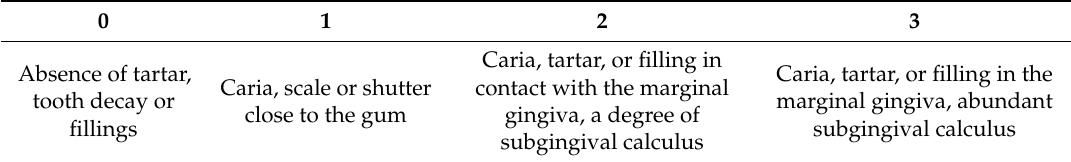
Table 1. Oral hygiene